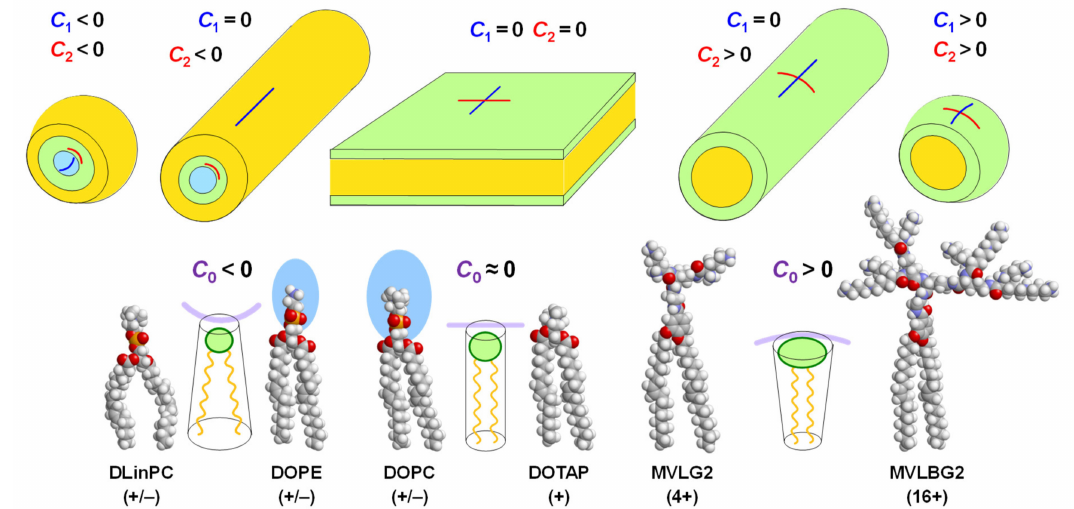
Figure 4. Relation of lipid shape and the resulting self-assemblies. Inverse-cone-shaped lipids give rise to inverse micellar structures ( left ); cylindrical lipids ( center ), where the headgroup area approximately matches the projected area of the tails, prefer (nearly) flat membranes (lamellar phases and large vesicles, depending on water excess); cone-shaped lipid ( right ) prefer micellar structures such as cylinders of varying length and spheres. Blue and red lines indicate the membrane curvatures C 1 and C 2 , respectively, of the assemblies. Purple lines behind the schematic depictions of lipids with different shapes indicate the spontaneous curvature C 0 of their assemblies. See Figures 2–4 for the chemical structures of the displayed